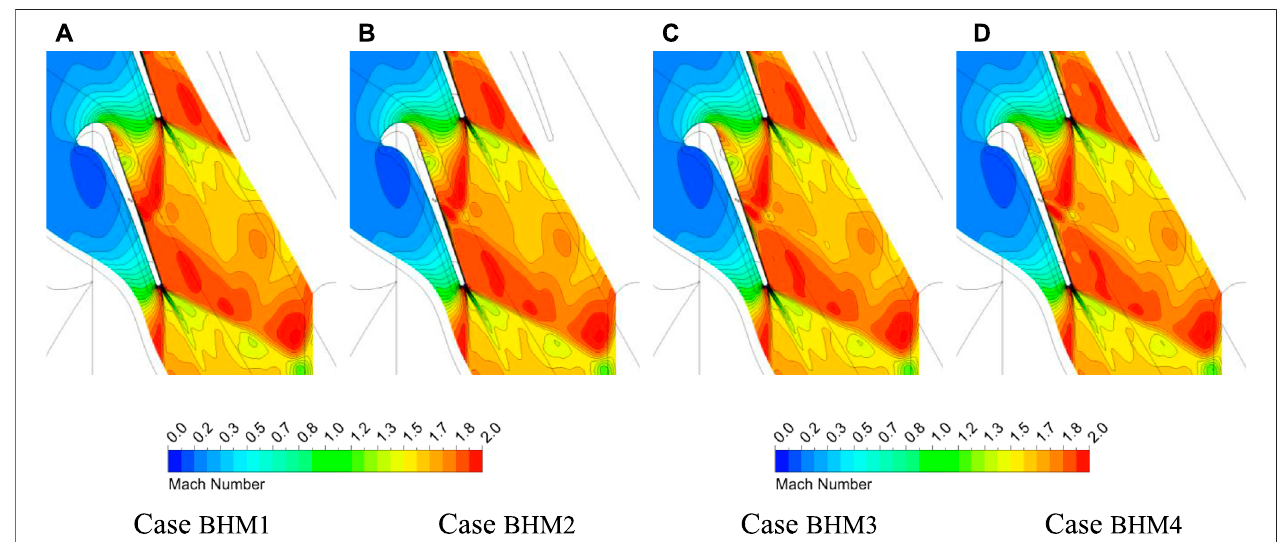
FIGURE 9 | Density gradient distribution in the different height sections of high-degree-of-reaction (DOR) blade airfoil. (A) h/L = 10% and (B) h/L = 50%.